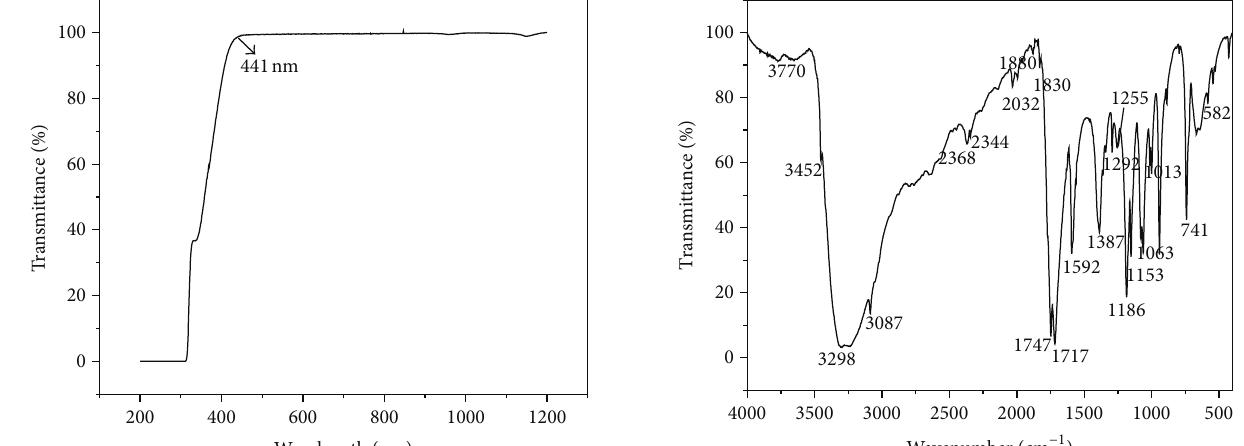
F 3: FTIR spectrum of Cu